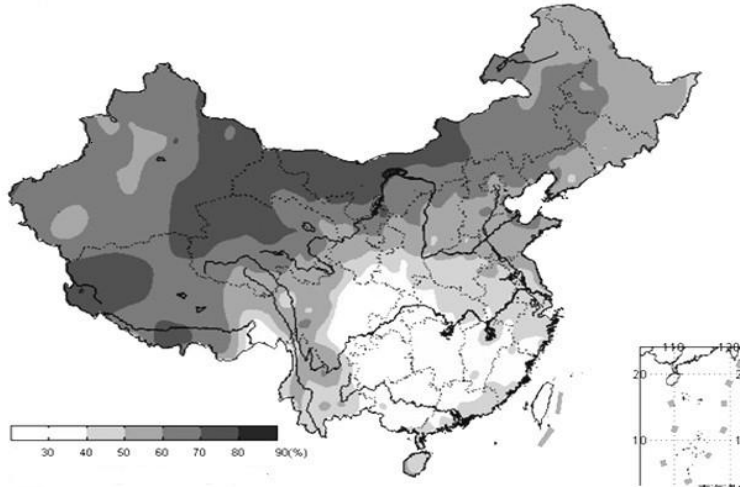
Figure 2. Annual average percentage of sunshine in China (Source: National Meteorological Information Center).